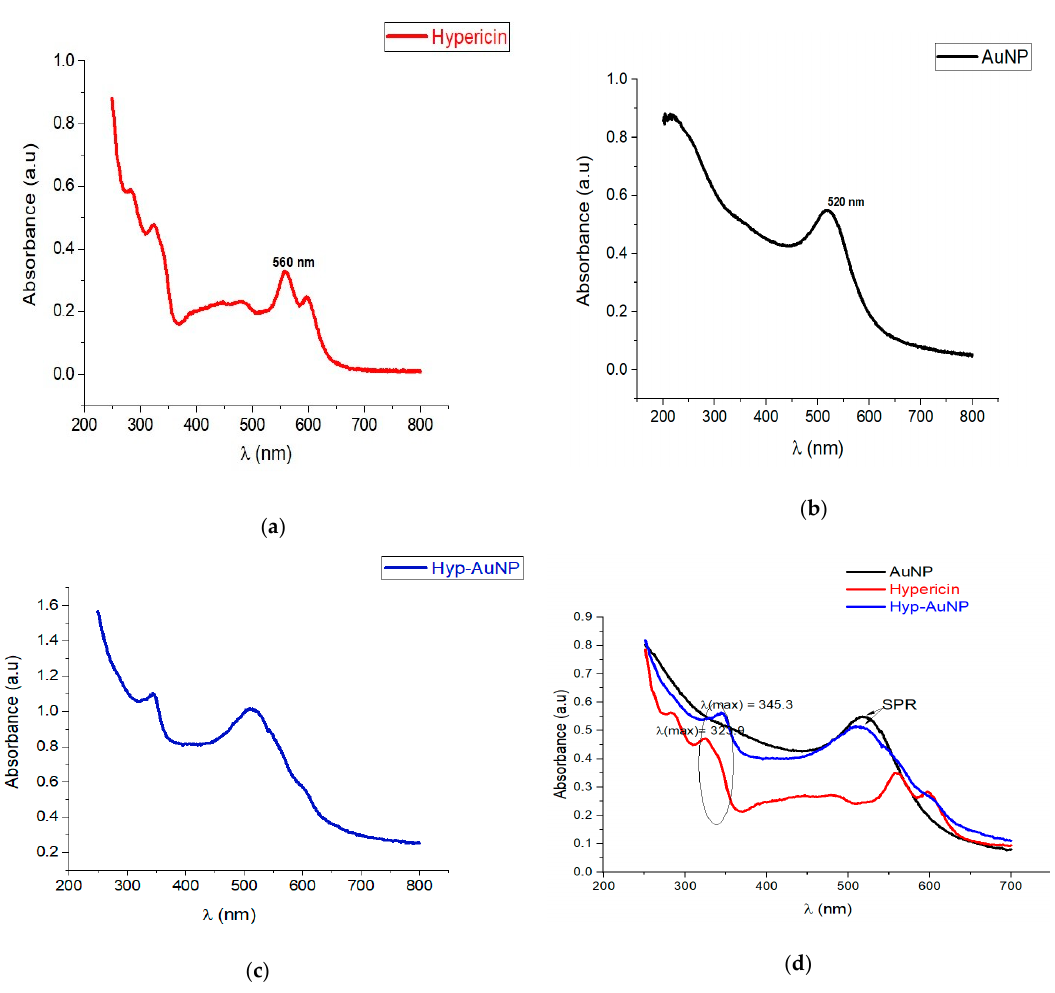
Figure 1. UV-Vis characterization of Hyp-AuNP compound compared to AuNP surface plasmon resonance (SRP) and hypericin peaks ( a ) AuNP spectra, ( b ) hypericin spectra, ( c ) compound spectra, ( d ) mirrored plots.